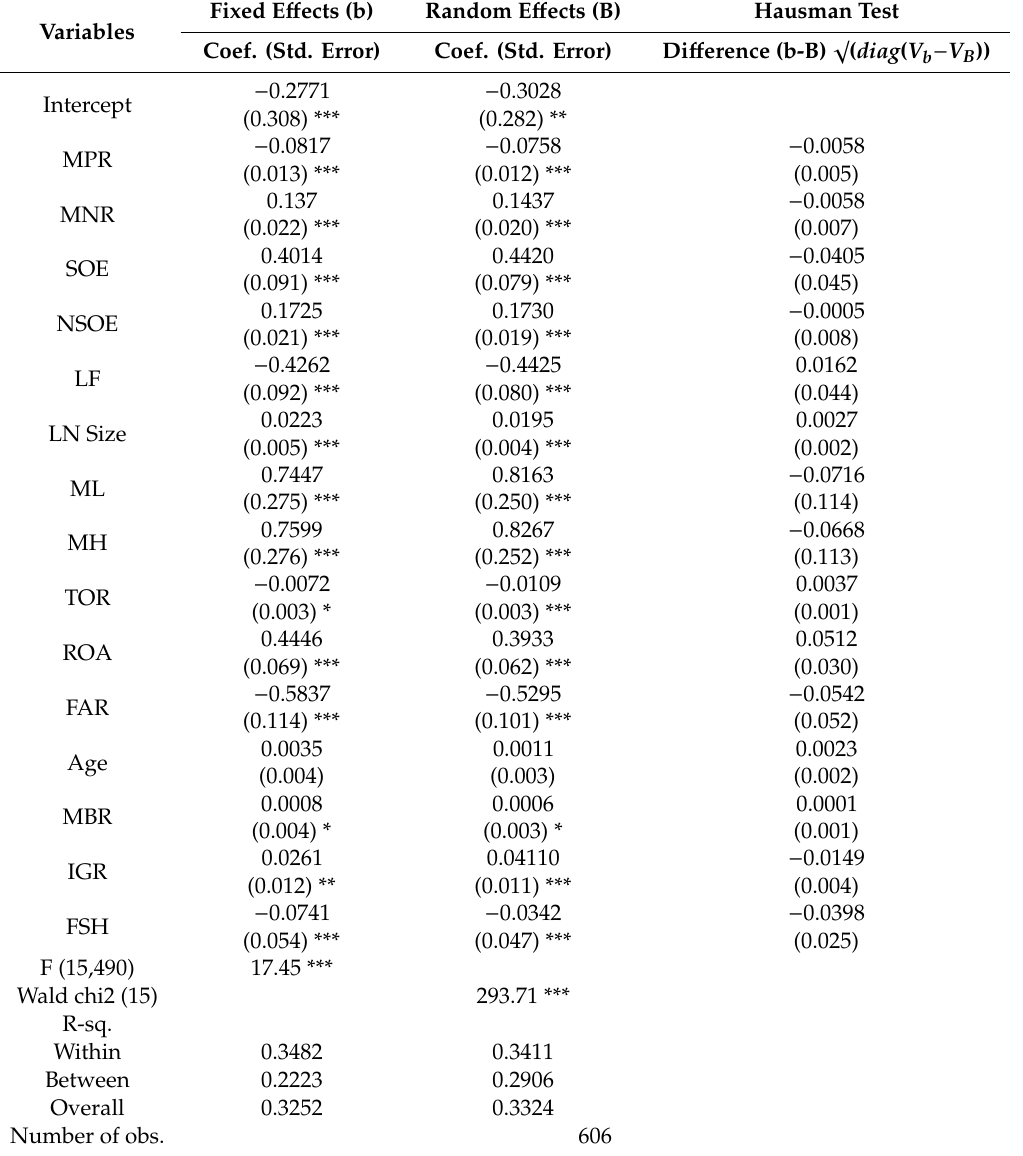
Table 7. Financial impact of CDI on companies SOE / NSOE and MPR /